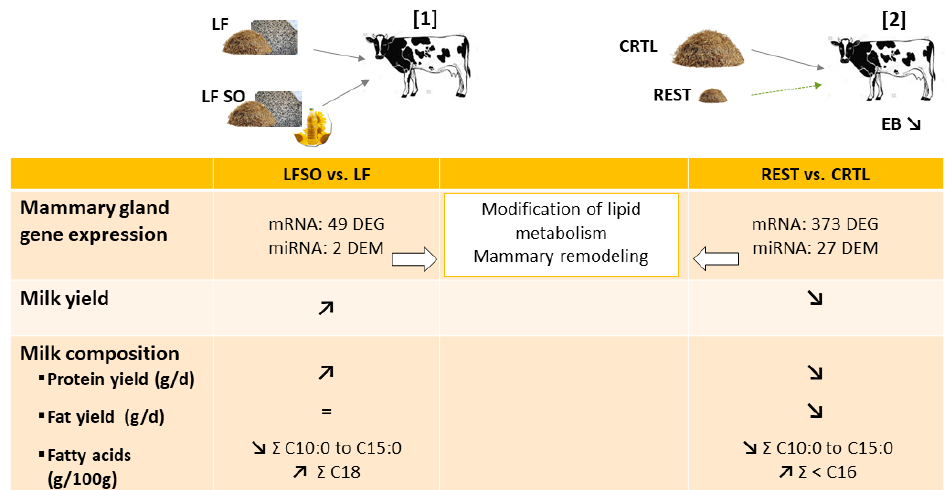
Figure 3. Effects of sunflower supplementation and restricted diet on milk and mammary gene expression. Reprinted with permission from ref. [1] Copyright 2019 Cambridge Core; Reprinted with permission from ref. [2] Copyright 2021 MDPI. CTRL: control diet; DEG: differentially expressed mRNA; DEM: differentially expressed microRNA; EB: energy balance; LF: low forage; LFSO: low